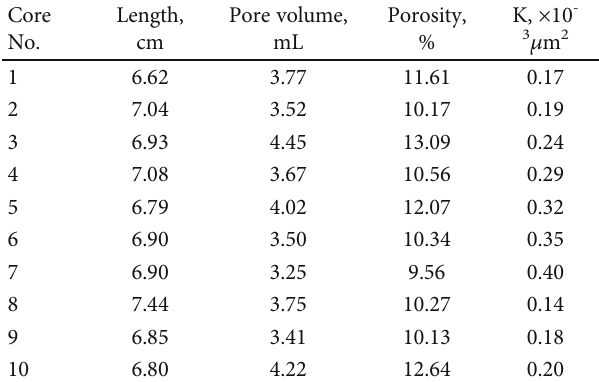
Table 2: Basic parameters of the core samples.